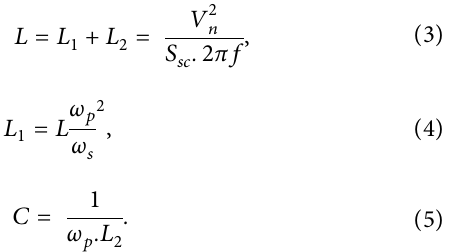
Table 2: Typical phase angle spectrum-phase A. θ h Harmonic order % I nom